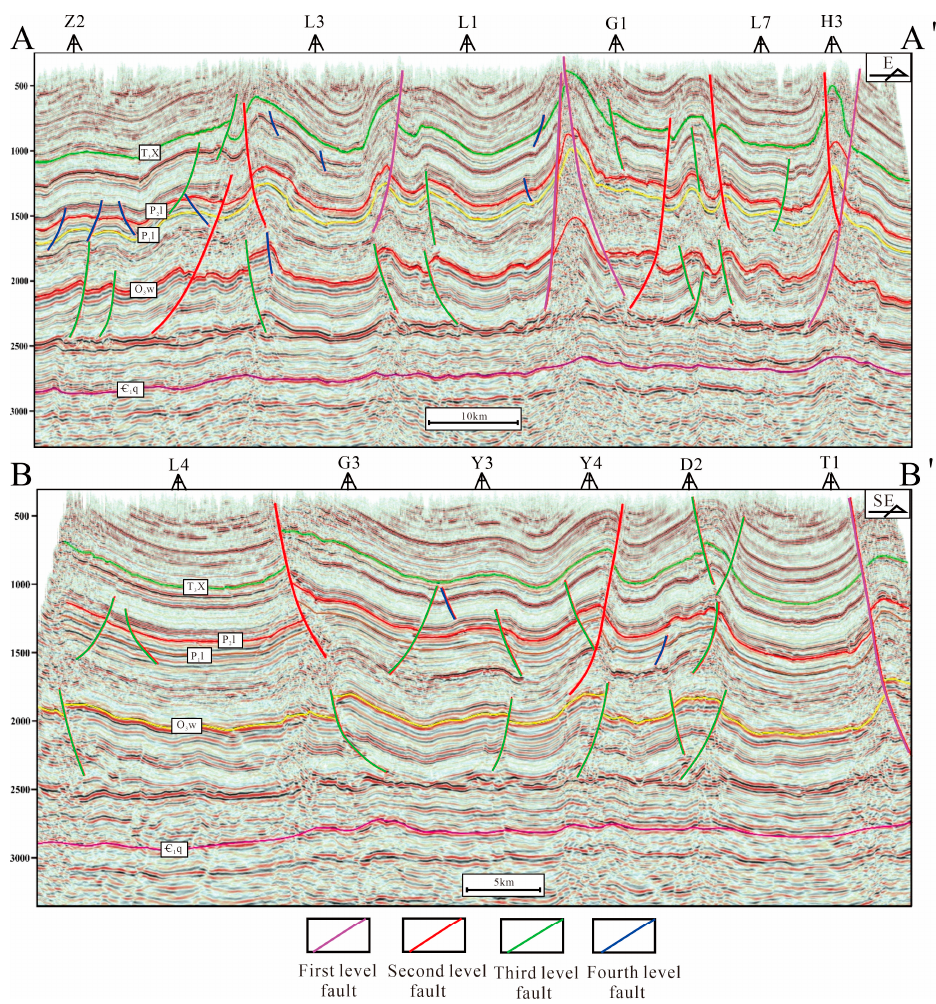
Figure 6. A structural interpretation of the seismic profile in the Luzhou area.